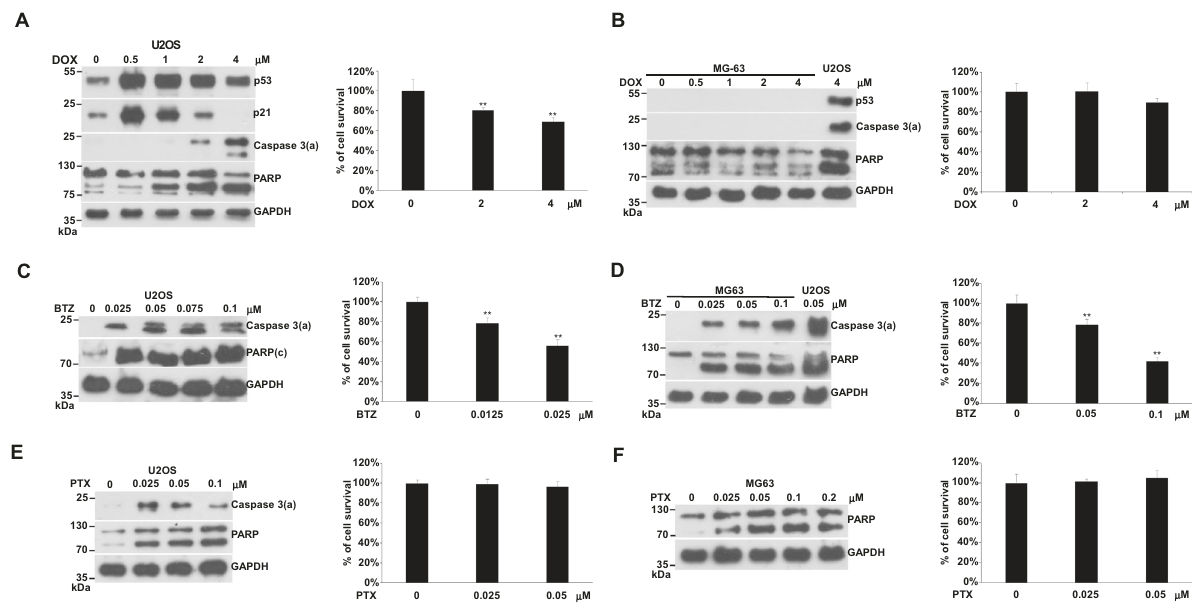
Fig. 1 Effects of DOX, BTZ, and PTX on apoptosis in U2OS and MG63 cells. Cells were incubated with various concentrations of DOX, BTZ, or PTX in 10-cm plates or 96-well plates for 24 h and harvested for western blotting or cell survival assay, respectively. The immunoblot images of p53, p21, caspase 3(a), or PARP were shown. GAPDH served as a loading control. The percentages of cell survival normalized to the cells without compound treatment were shown beside the right side of the immunoblot image (** P < 0.01). The immune blots were cropped from different parts of the same gels and visualized by ECL under various exposure conditions dependent on the activity of antibodies. Representative blots from triplicate experiments were shown. A U2OS was treated with DOX. B MG63 treated with DOX. C U2OS treated with BTZ. D MG63 treated with BTZ. E U2OS treated with PTX. F MG63 treated with